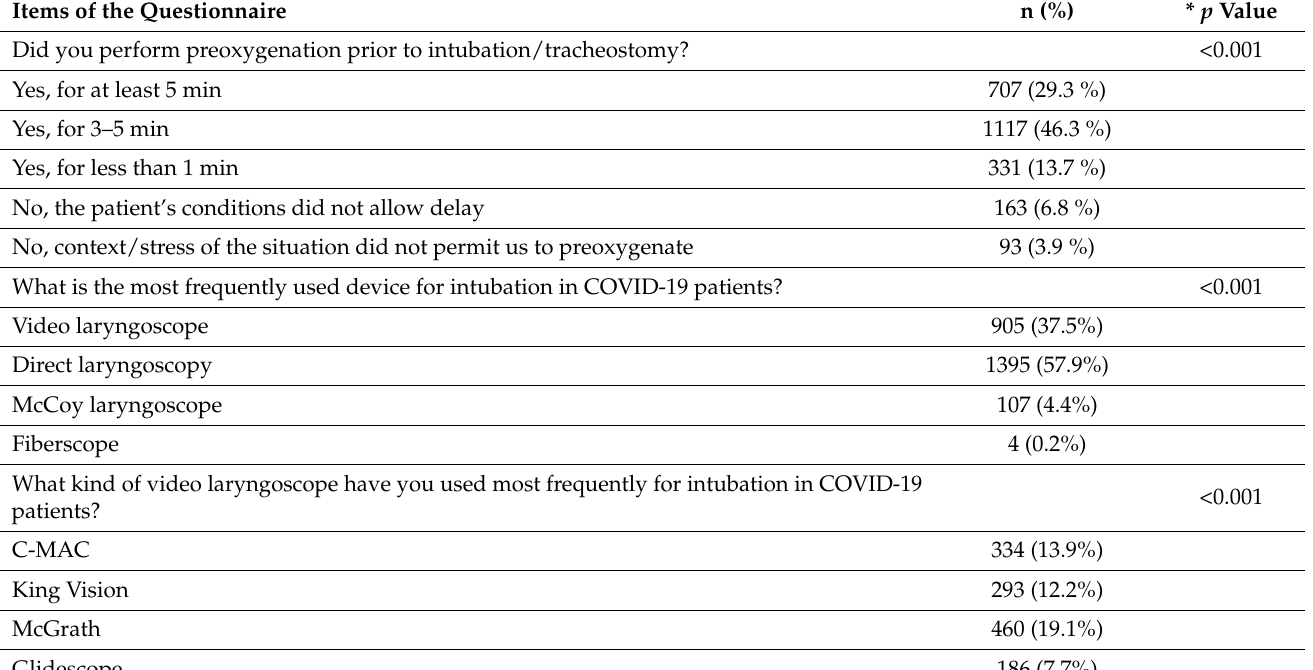
Table 4. Techniques in airway management of patients with COVID-19 reported by